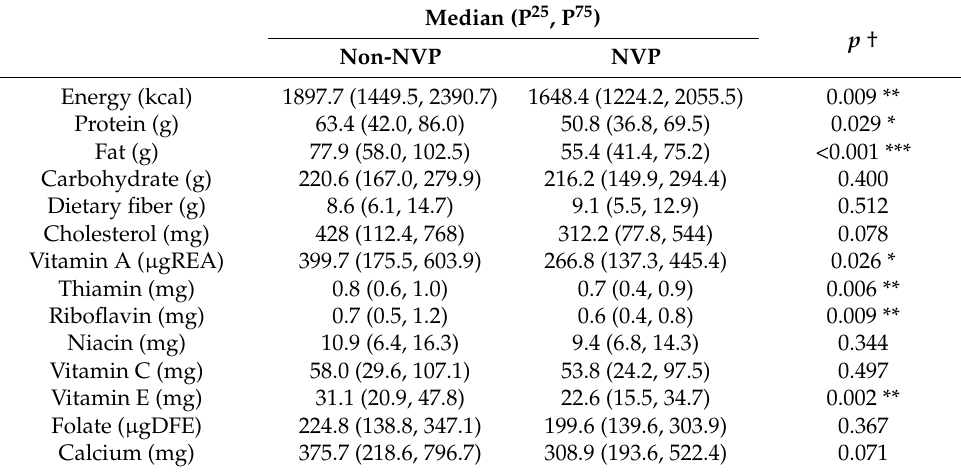
Table 2. Comparison of dietary nutrient intake between pregnant women with and without nausea and vomiting in early